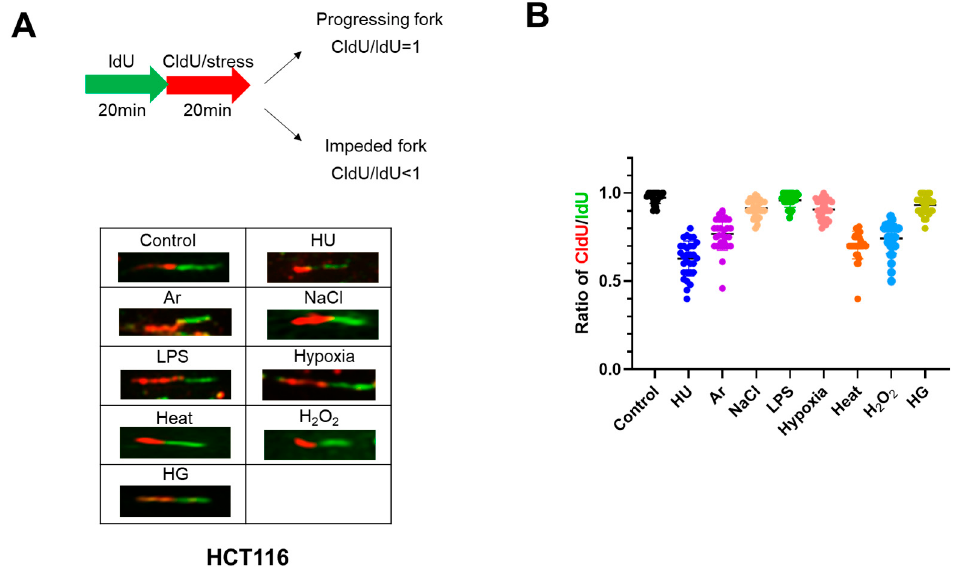
Figure 2. Various biological stresses influence DNA replication to different extents. ( A ) U2OS cells were treated with indicated biological stresses for 3 h. The nucleotide analog BrdU was added for 15 min before the cell harvest. Cells were then stained with anti-BrdU antibody and propidium io- dide (PI); 1×10 4 cells were analyzed by flow cytometry. Representative images were shown. Upper, BrdU incorporation (DNA synthesis); lower, cell cycle (DNA content). ( B ) Fractions of BrdU-posi- tive cells in stress-treated cells (gated in A) were measured and are presented.